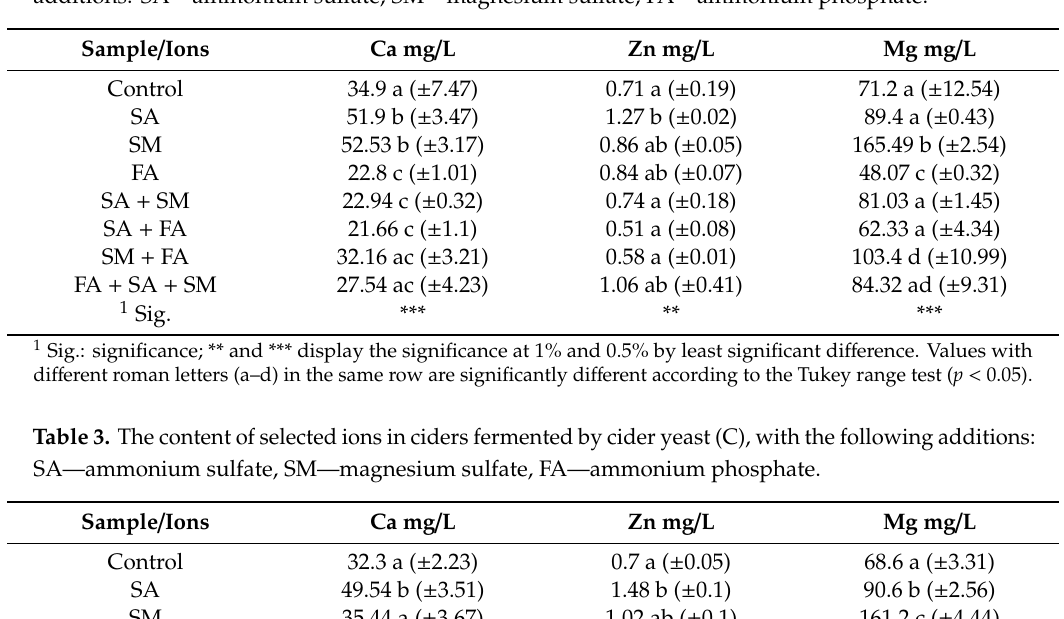
Table 2. The content of selected ions in ciders fermented by distiller’s yeast (G), with the following additions: SA—ammonium sulfate, SM—magnesium sulfate, FA—ammonium phosphate.